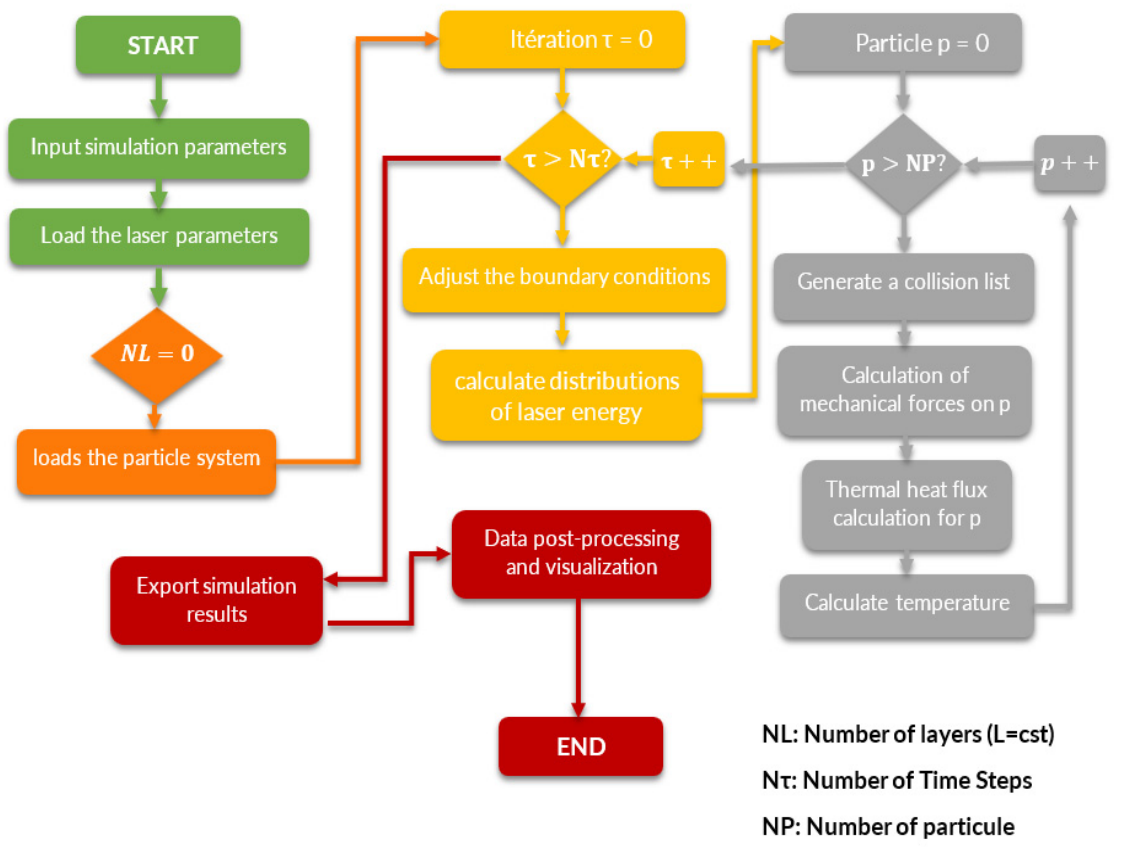
Figure 9. Flowchart in the Python implementation of the DEM framework.